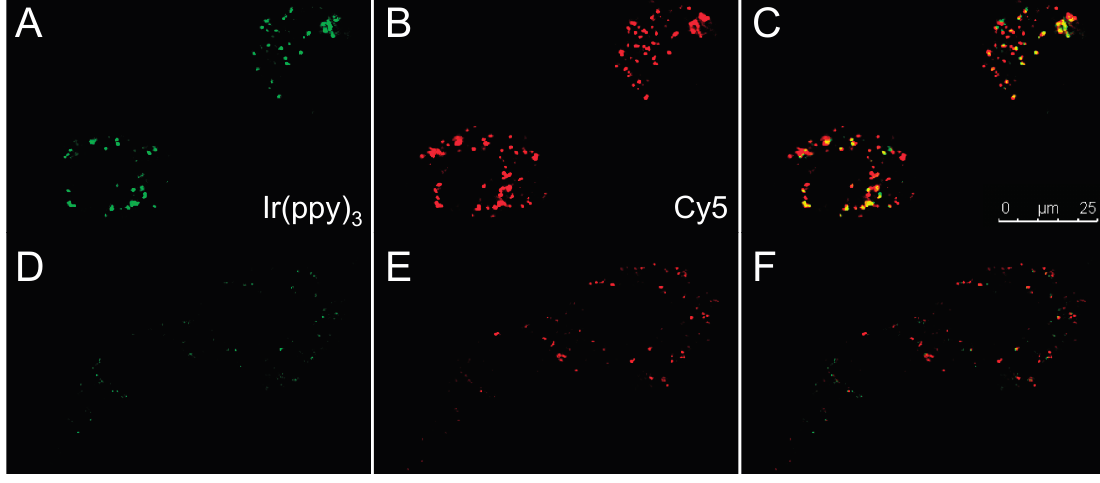
Figure 5. Confocal images of SKOV-3 cells after 24 h incubation with 3L ( A – C ) or 3D ( D – F ). ( A , D ) Ir(ppy) 3 channel in green; ( B , E ) Cy5 channel in red; ( C , F ) Overlay of both channels. Yellow means colocalization of red and